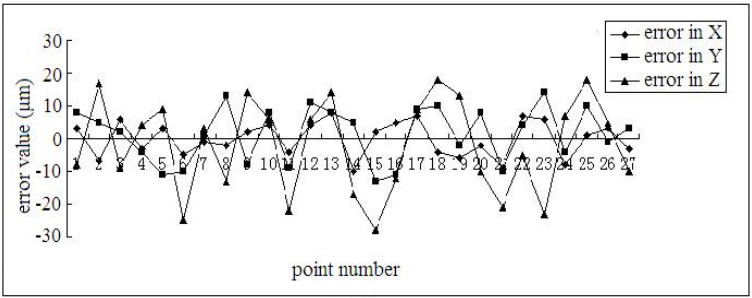
Figure 10. Variation of error caused by straightness motion error.